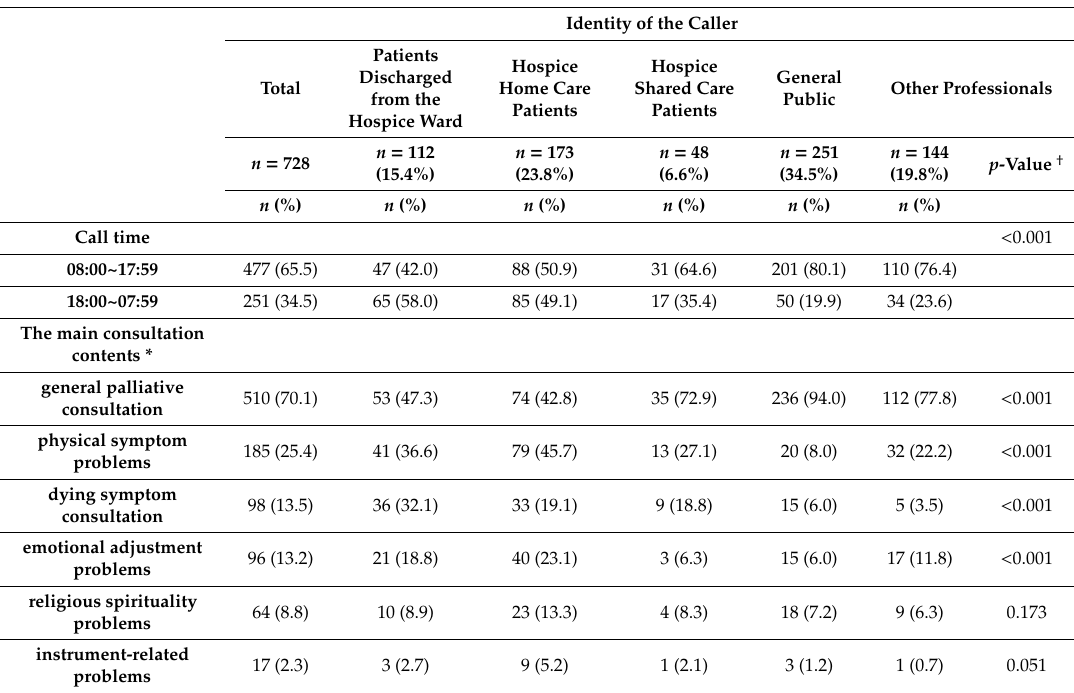
Table 1. Comparison of phone call time and consultation content of 24-hour specialist palliative care telephone advice service by caller’s